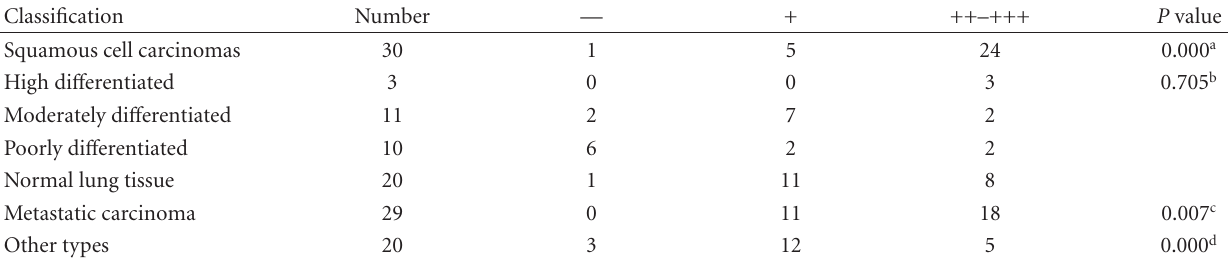
Table 4: S100A8 expression in various tissues by